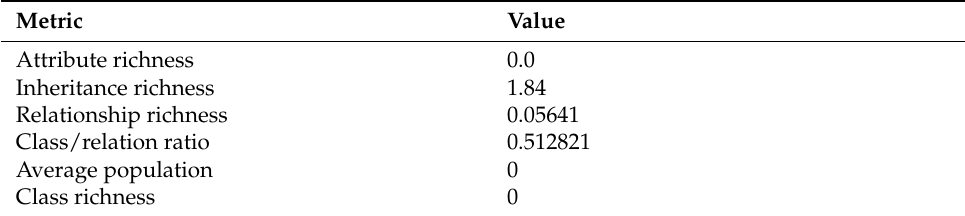
Table 3. The Lunyu ontology advanced